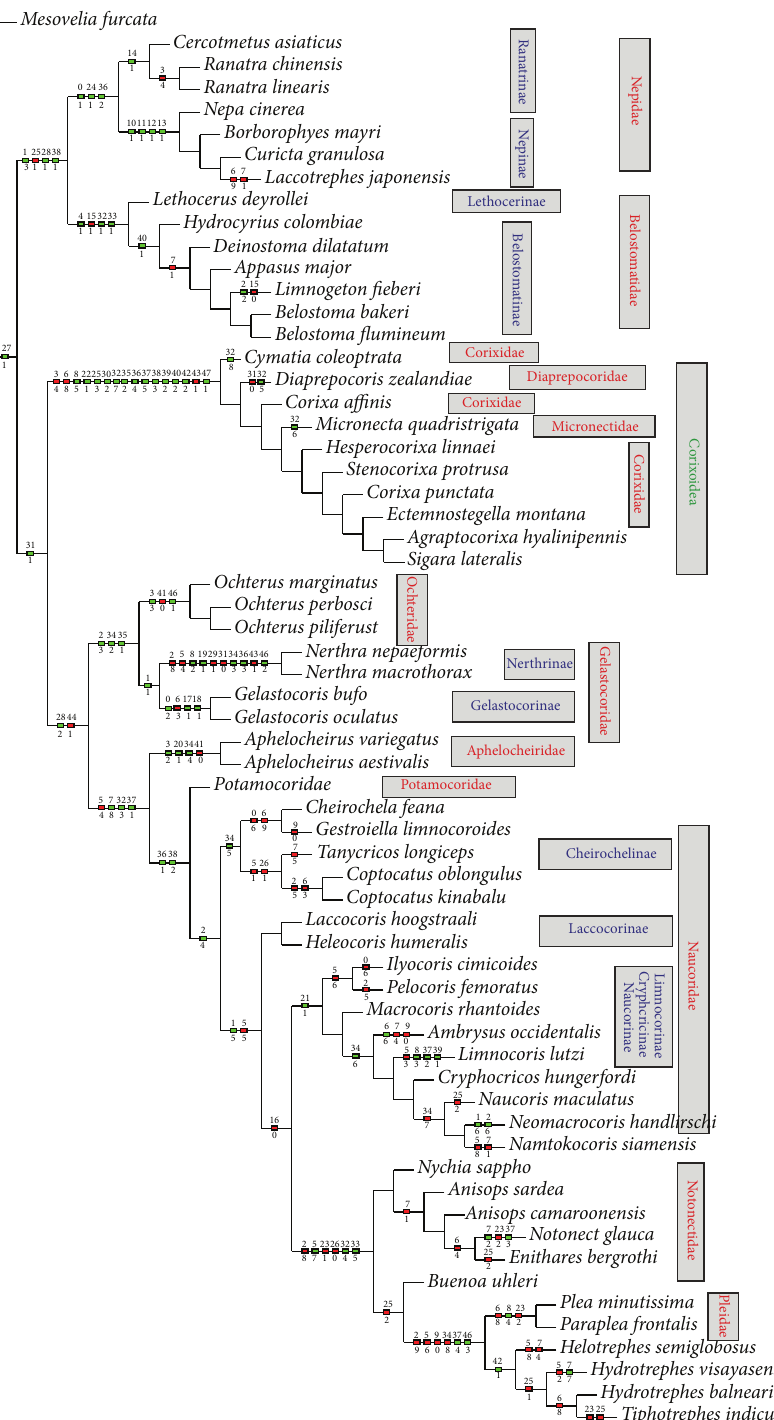
Figure 4: The most parsimonious tree resulting from the heuristic search with characters treated as unordered and equally weighted (tree length = 198, consistency index = 71, retention index = 92). A small green box indicates nonhomoplasy (synapomorphies and autapomorphies); a red small box indicates homoplasy. The number above the branch line refers to the number of a character; the number below the line of the branch refers to number of the state of a character. The unambiguous option is